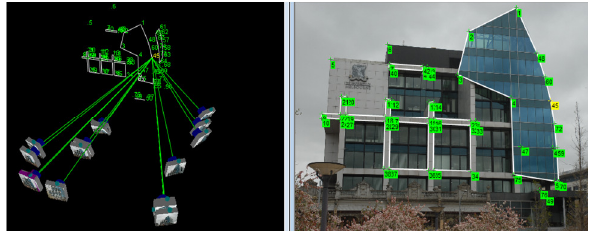
Figure 7. 16-image, 12-zoom setting, 72-point test network for Z-D calibration method